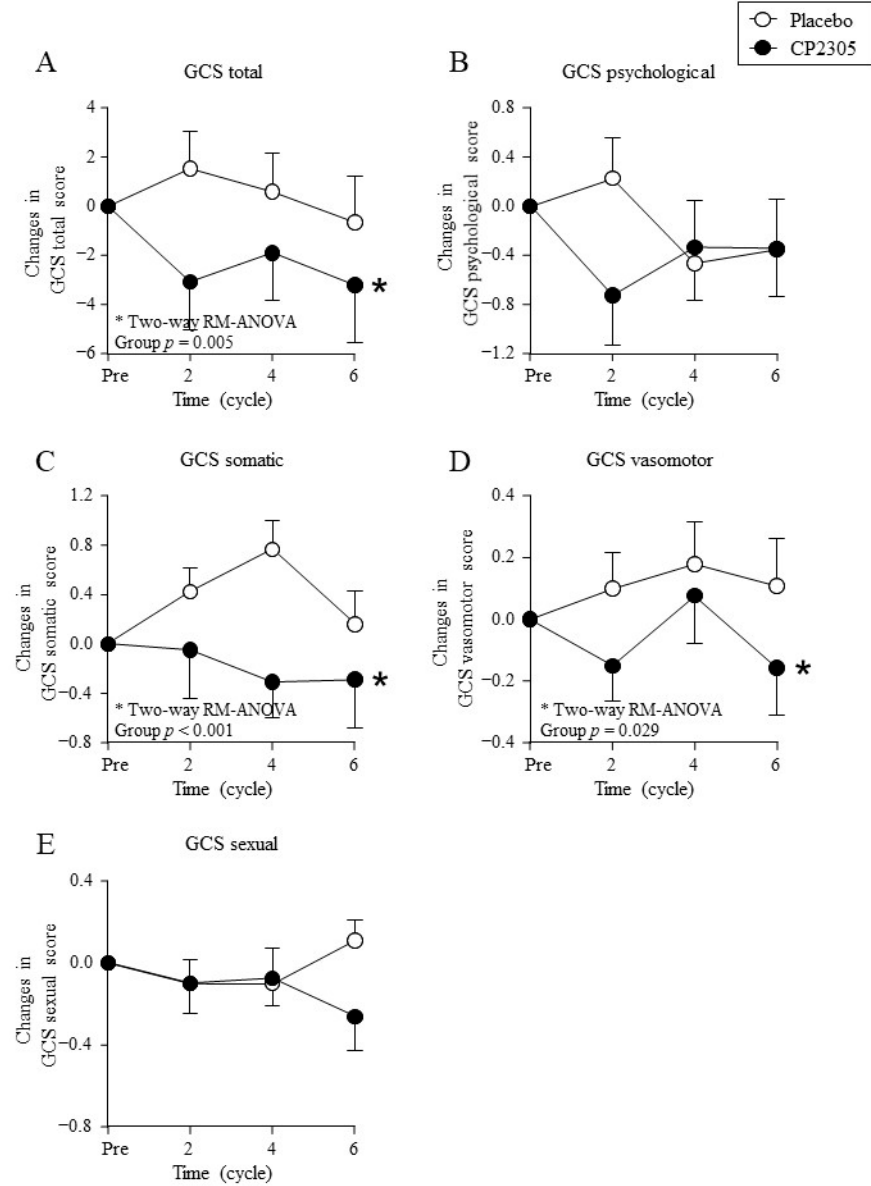
Figure 3. Changes in the Greene climacteric scale (GCS) during treatment. Points represent ( A ) changes in GCS total score, ( B ) changes in GCS psychological score, ( C ) changes in GCS somatic score, ( D ) changes in GCS vasomotor score, and ( E ) changes in GCS sexual score. * represents statistical difference between groups by two-way repeated measures (RM) ANOVA (detailed statistical results in Supplementary Materials Table S1). The baseline score values, post-intake score values, and percent reduction calculated using these two scores are summarized in Supplementary Materials Table S2.